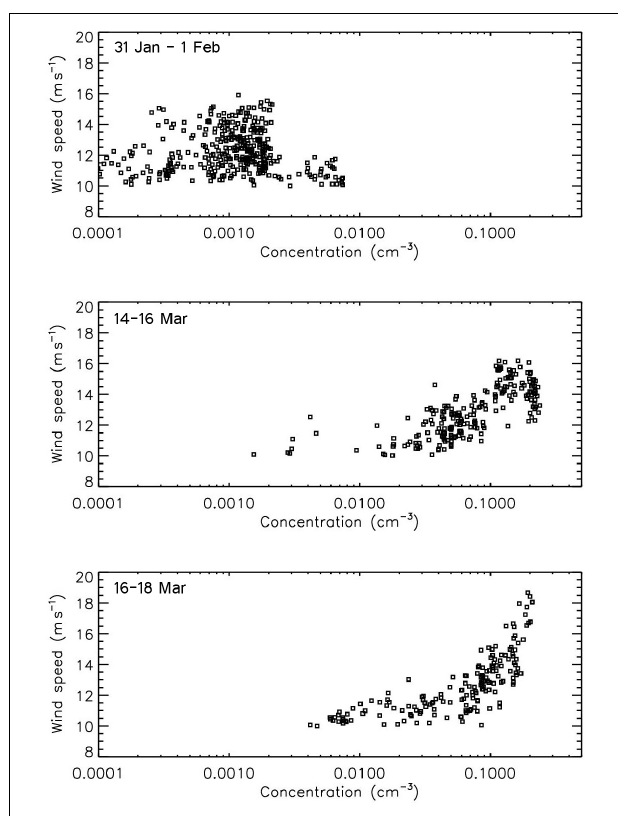
FIGURE 8 | Particle size class 5–12.5 µ m aerosol concentration and wind speed relationship for the three major dust